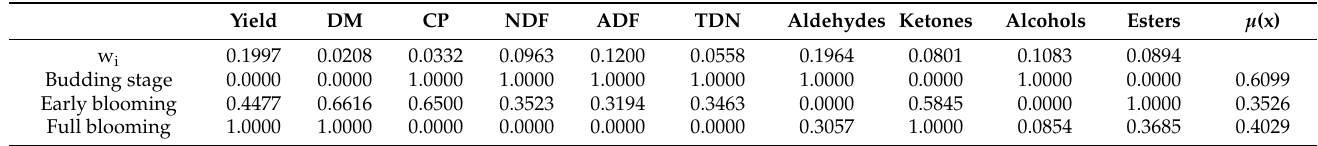
Table 2. Quality ranking of alfalfa at different harvest